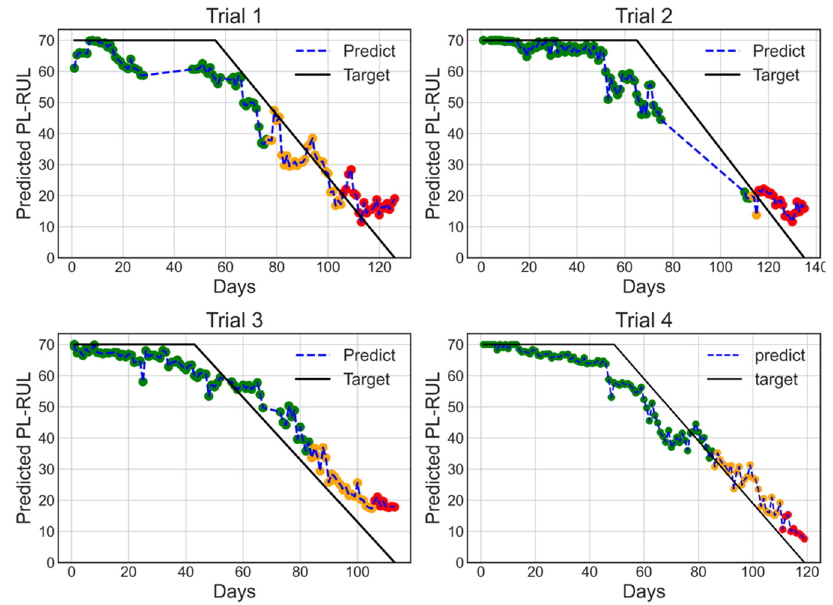
Figure 14. 4-fold cross-validation results with = selected using Method 2 on A/C dataset using ERTs regressor. This result has the lowest averaged RAE.